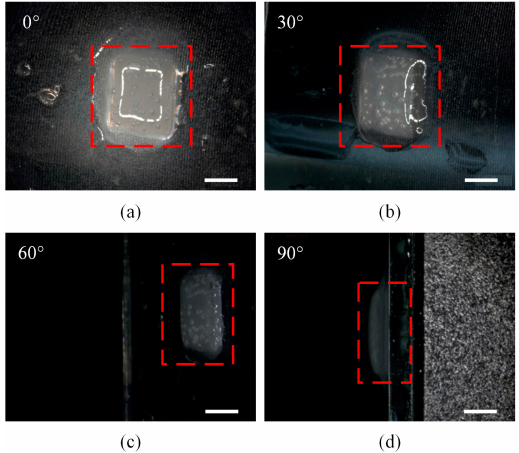
Figure 3. Hydrogel of quadrangle shape observed from ( a ) 0°; ( b ) 30°; ( c ) 60° and ( d ) 90°. Hydrogel is framed by red dashed line. The scale bar is 2 mm.